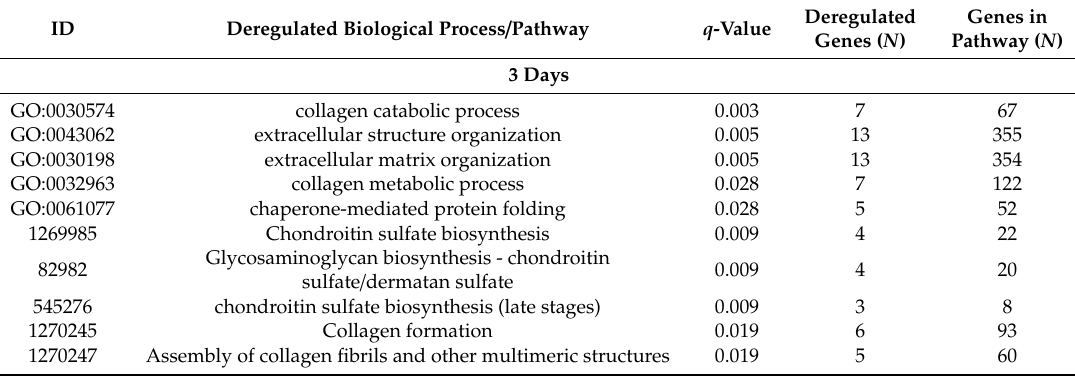
Table 1. Selected biological processes and pathways deregulated after inhalation of CuO